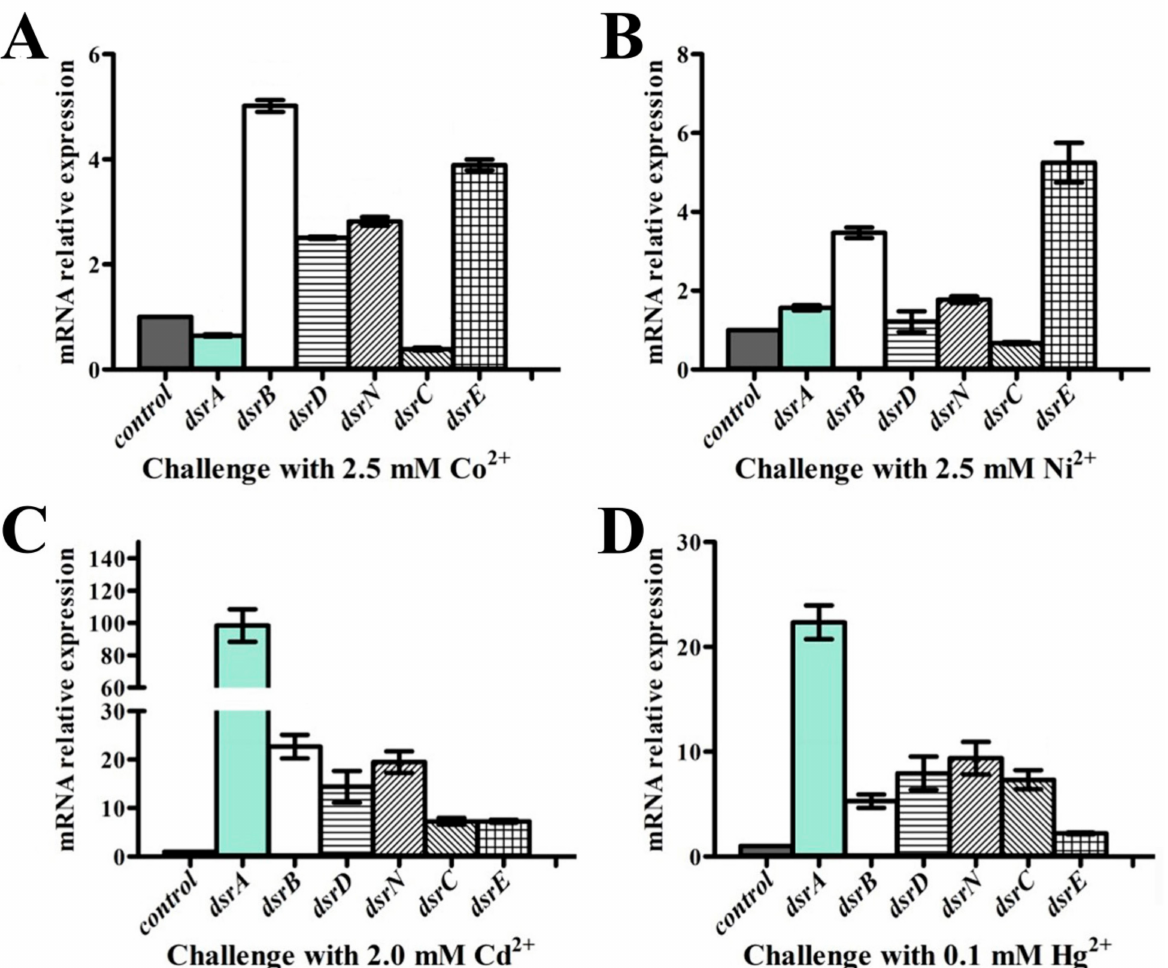
Figure 5. Quantitative real-time polymerase chain reaction (qRT-PCR) analysis of the expression of genes within dsr -operon of P. cashew SRB007 challenged with 2.5 mM Co 2+ ( A ), 2.5 mM Ni 2+ ( B ), 2.0 mM Cd 2+ ( C ) and 0.1 mM Hg 2+ ( D ),